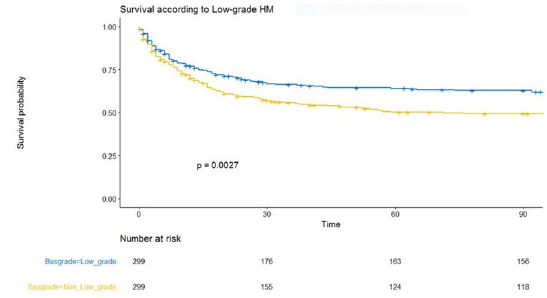
Fig. 1 Survival probability according to underlying malignancy after propensity score